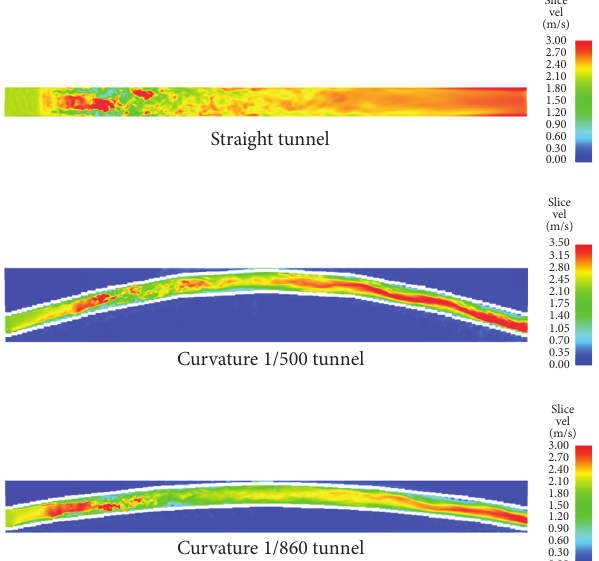
Figure 10: Velocity field in the human eye height plane.